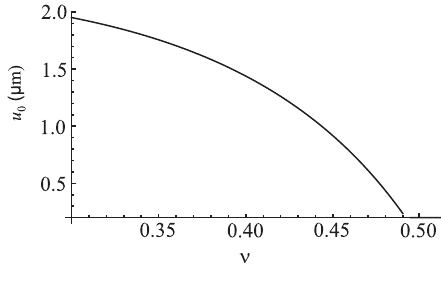
Figure 3. Initial displacement u 0 vs Poison’s